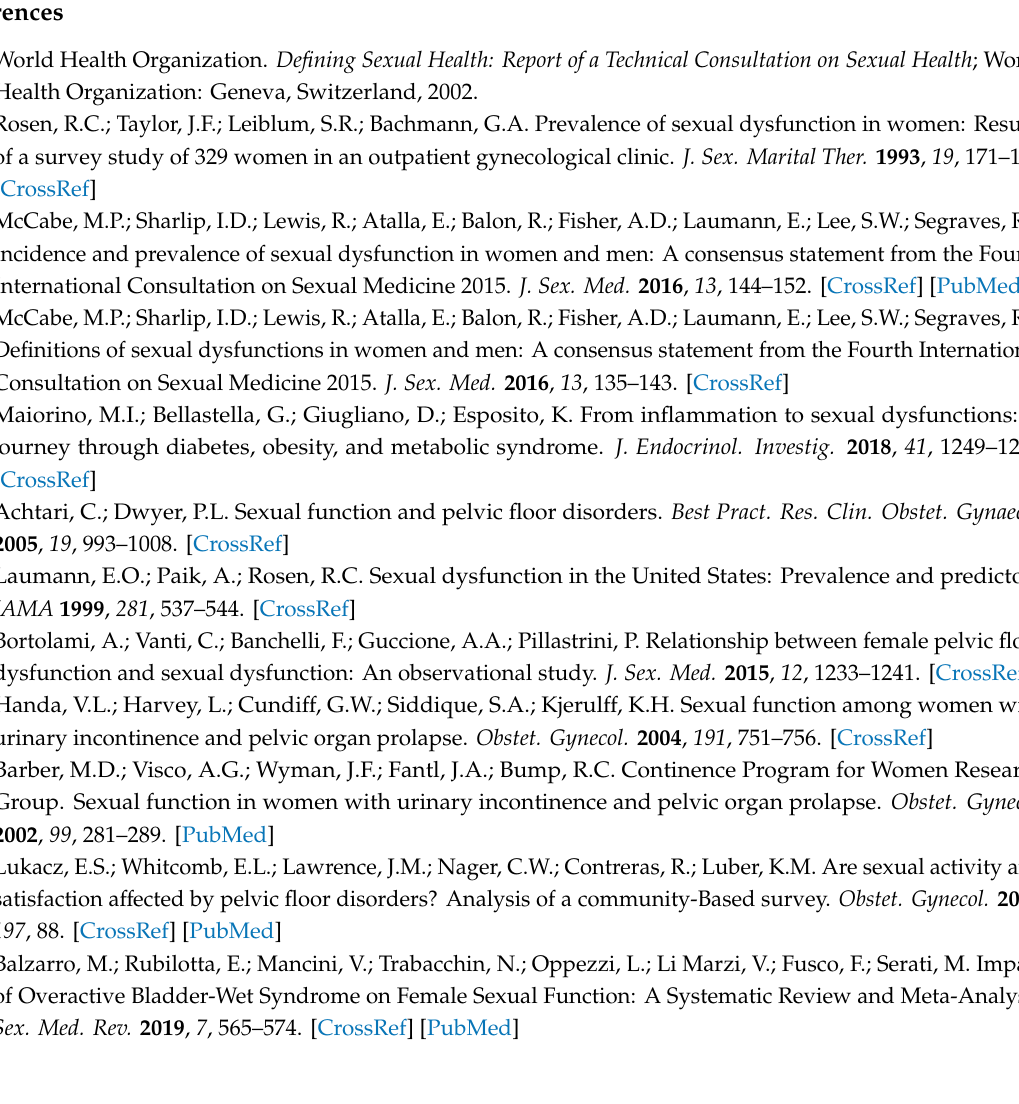
Table S1: STROBE Statement, Table S2: Spanish FSFI ( Í ndice de la Funci ó n Sexual Femenina ) and